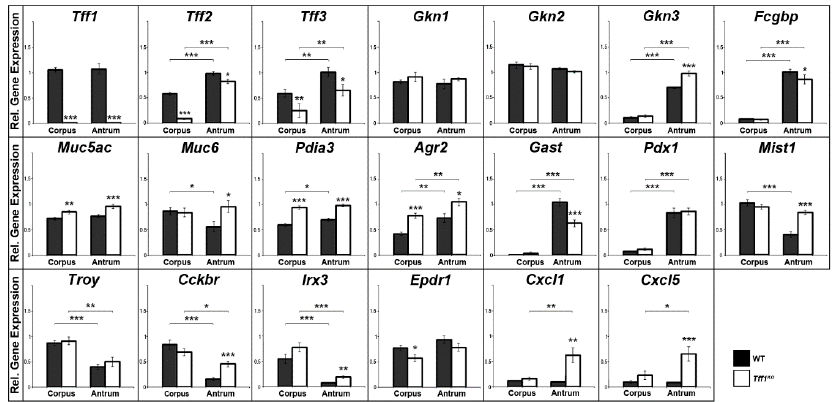
Figure 1. Semi-quantitative RT-PCR analyses. Tff1 (21x), Tff2 (20x), Tff3 (30x), Gkn1 (21x), Gkn2 (22x), Gkn3 (24x), Fcgbp (31x), Muc5ac (25x), Muc6 (27x), Pdia3 (25x), Agr2 (24x), Gast (26x), Pdx1 (33x), Mist1 (35x), Troy (35x), Cckbr (33x), Irx3 (35x), Epdr1 (33x), Cxcl1 (32x), and Cxcl5 (32x) expression was monitored in the corpus and antrum of 10 male wild-type (WT) and 10 male Tff1 KO mice. The relative gene expression levels were normalized against β -actin ( Actb , 24x). The number of amplification cycles is given in parentheses. Significances are indicated by asterisks (*, p ≤ 0.05; **, p ≤ 0.01; ***, p ≤ 0.001). WT animals: black bars; Tff1 KO animals: white bars.